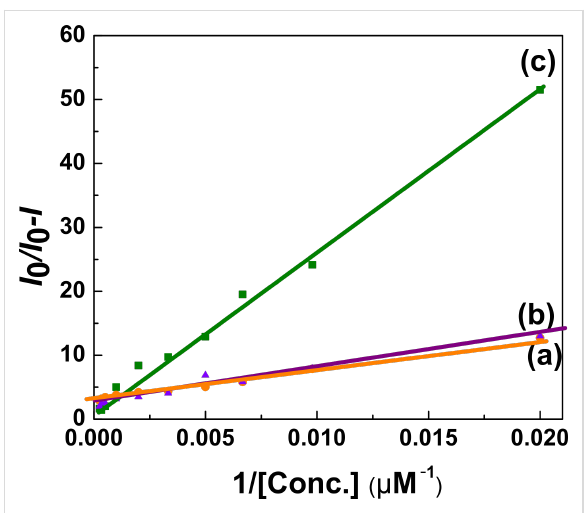
Figure 8: Modified Stern–Volmer plots of (a) P3HT:CISe, (b) P3HT:CIGSe and (c) P3HT:CZTSe nanocomposites.